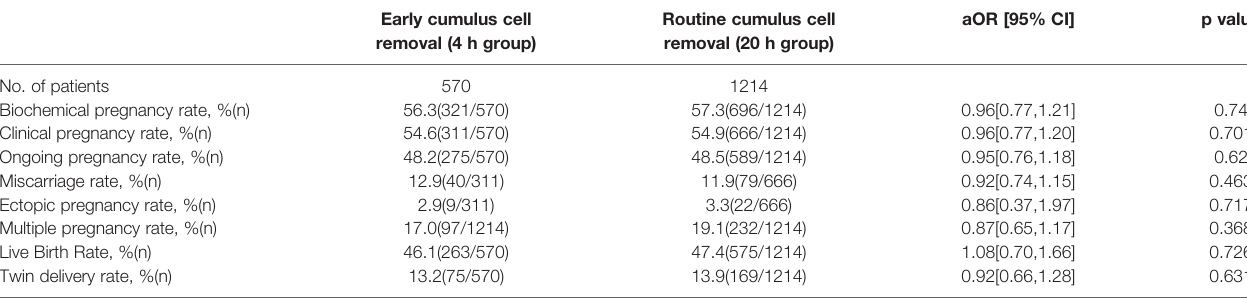
TABLE 2 | Pregnancy outcomes of patients following fresh embryo